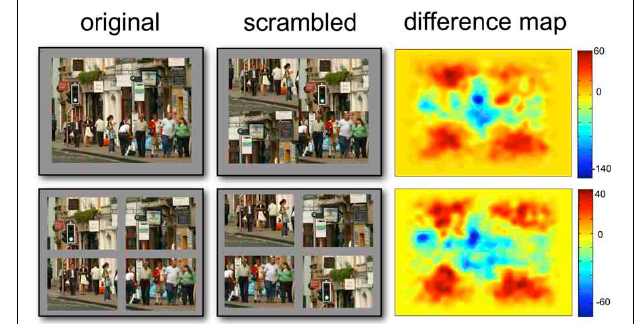
FIGURE 2 | Gaussian heat-maps of fixation distributions in Experiment 1. A half degree kernel smoothing was applied to the gaussians.